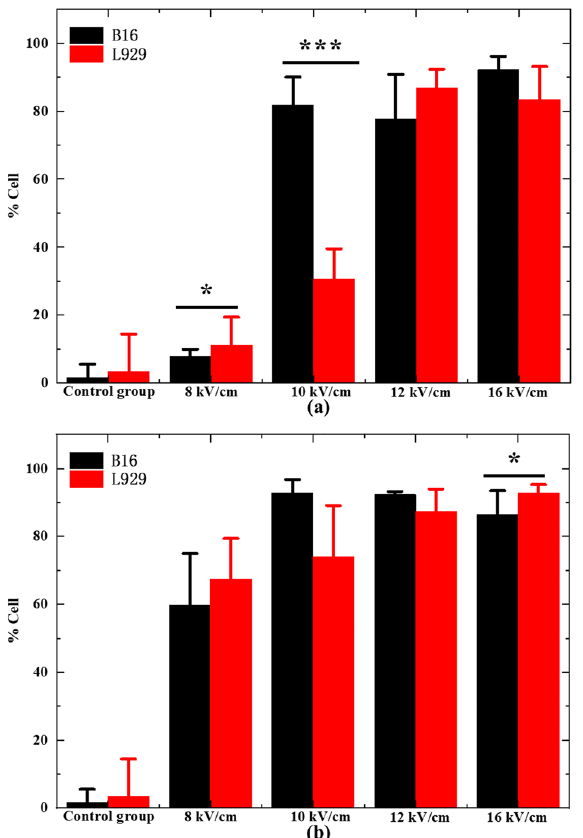
Figure 6. Comparison of cytotoxicity of B16 cells (black bar) and L929 cells (red bar) exposed to ( a ) 300 ns nsPEF and ( b ) 500 ns nsPEF at different intensities (8–10-12–16 kV/cm) incubated for 15 min before being assayed (* P < 0.05; *** P <